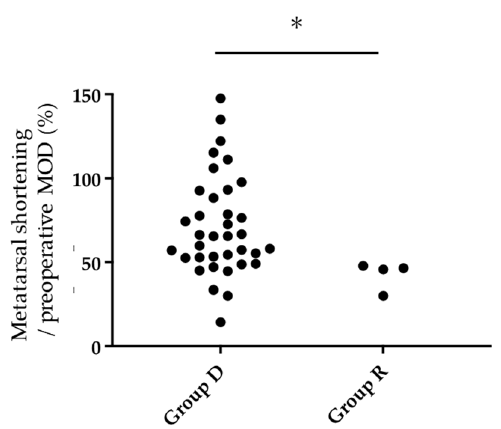
Figure 7. Assessment of metatarsal shortening length relative to the preoperative MOD. The ratio of metatarsal shortening length to the preoperative MOD (%) was significantly less in Group R with remnant callosities than in Group D without remnant callosities (Mann-Whitney U test, * p < 0.05) and <50% for all four toes.